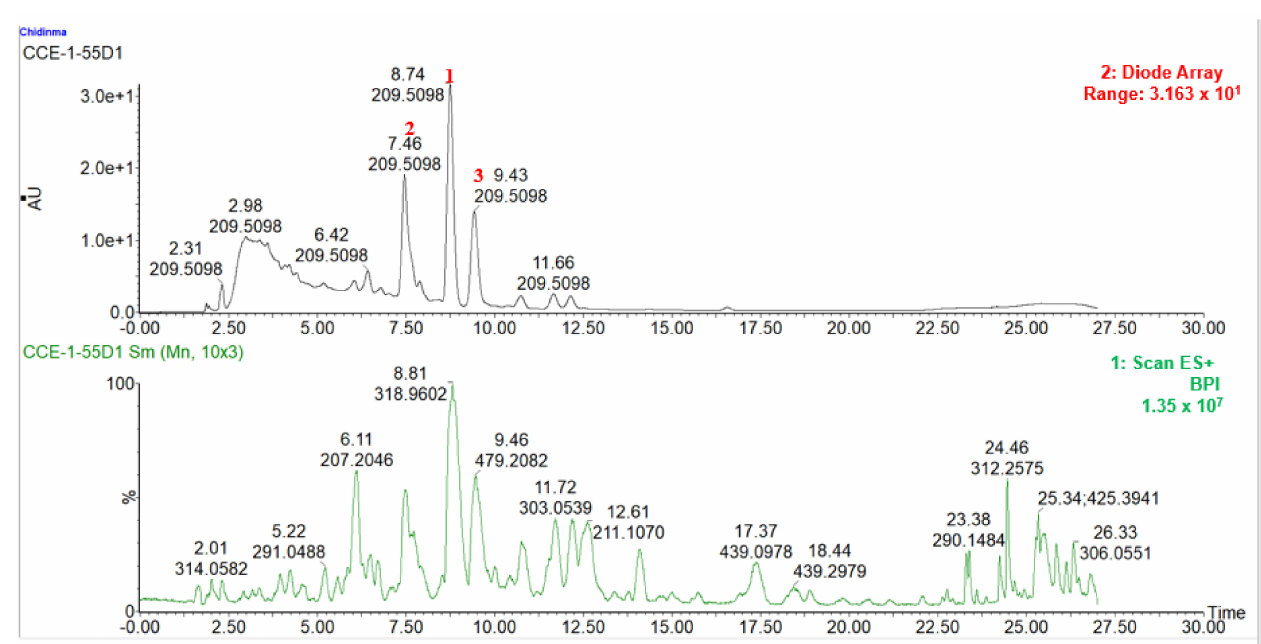
Figure 6. HPLC-UV max plot and MS positive mode chromatogram of Fraction 4.